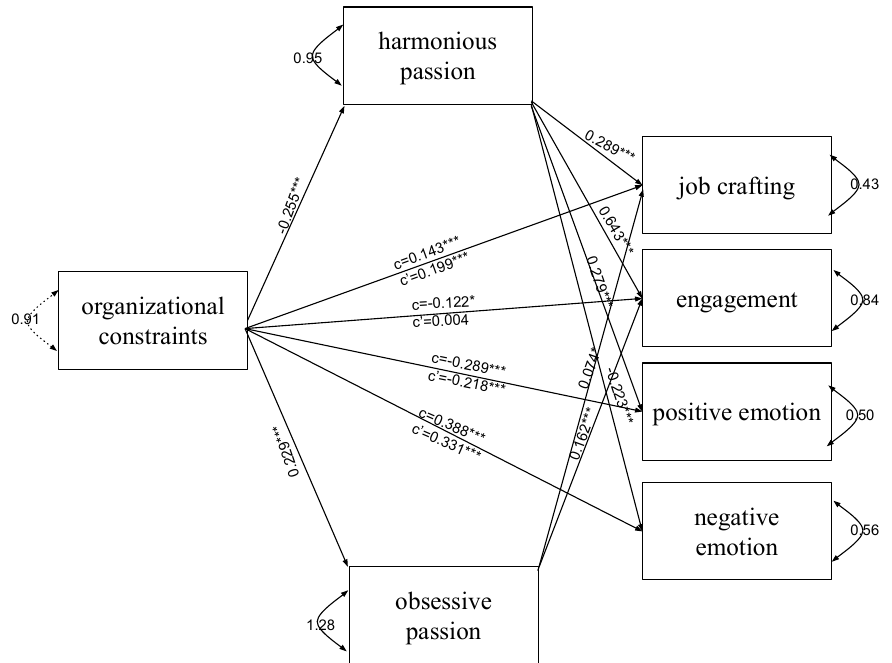
Figure 3. The final model with organizational constraints as an independent variable (model 2). The unstandardized path estimates (coefficients) were shown. Note. * p < 0.05; *** p < 0.001. Table 2. Detailed results for indirect effects in the relationship between workload and organiza- tional constraints and well-being indicators—job crafting, engagement, positive and negative emo- tions, considering the mediation of harmonious and obsessive passion, in subsequent models (1, 2).